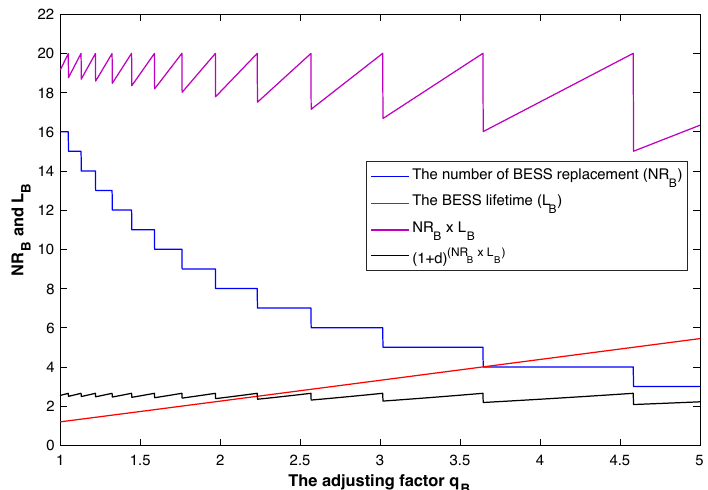
Figure 9. Relationships between NR B and L B for different values of q B